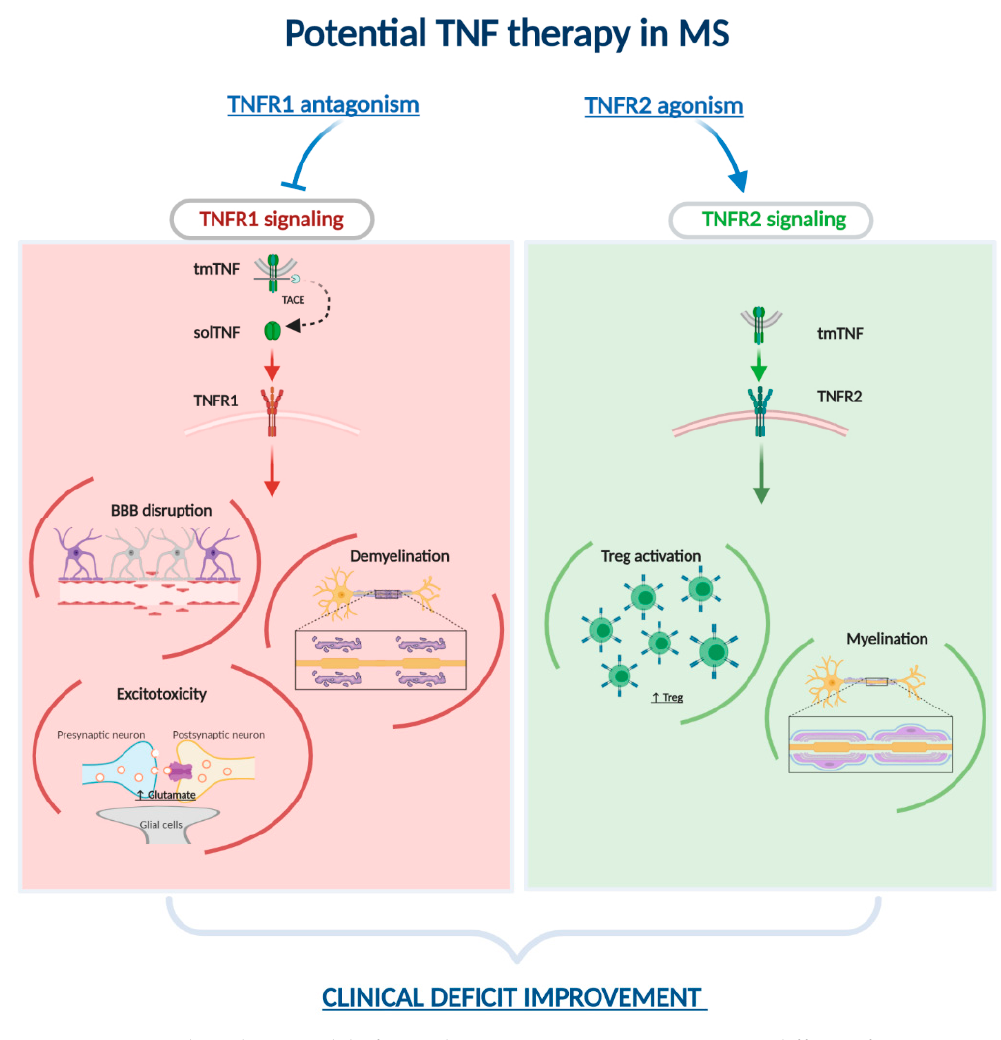
Figure 1. Potential working model of TNF therapy in MS. TNF exists in two different forms, tmTNF (transmembrane) and solTNF (soluble), this latter synthetized by TACE enzymatic activity and thus released only by TACE expressing cells. solTNF binds preferentially TNF receptor type-1 (TNFR1) while tmTNF recognizes type-2 (TNFR2). TNF and its receptors are involved in many pathological processes of MS. Signaling through TNFR1 is likely responsible for BBB disruption, demyelination